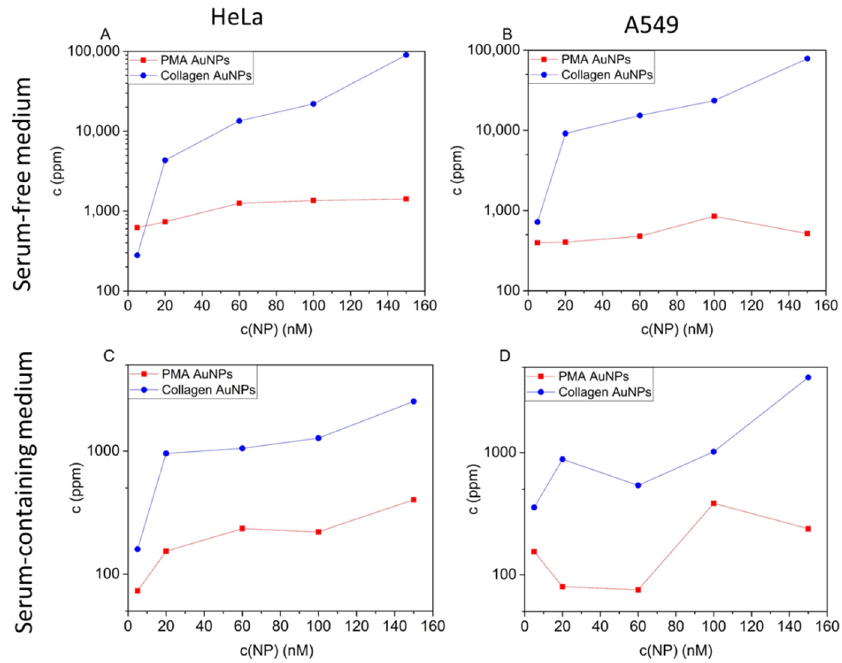
Figure 3. Internalization of Au NPs by cells. Collagen- and PMA-coated Au NPs were added to HeLa ( A , C ) or A549 ( B , D ) cells in medium without ( A , B ) and supplemented ( C , D ) with serum at different NP concentrations c (NP). After 4 h of incubation, the media with the excess of non-internalized NPs were removed, and the cells were thoroughly washed. The cells were cultured for an additional 20 h. The medium was then removed, and the cells were lysed. The samples were analyzed with ICP-MS, and the amount of internalized elemental gold c (Au) was determined. The lines between the individual points are merely intended as a guide to the